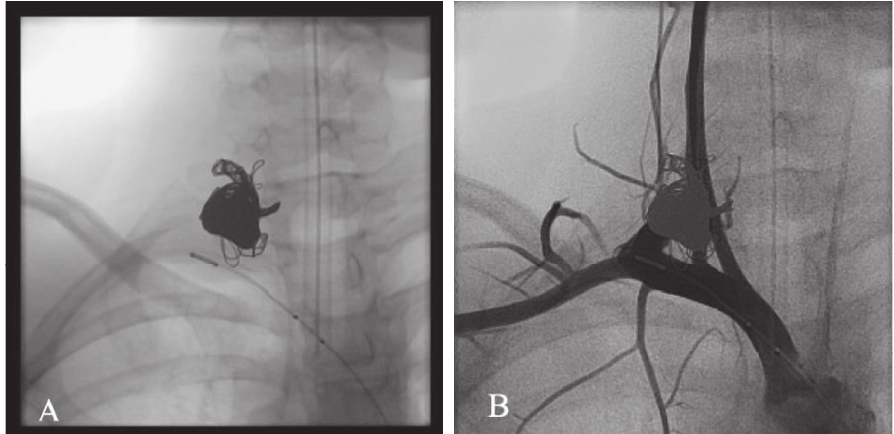
Figure 4: Images from the conclusion of the case demonstrating the mass of coils after occlusion (a) and filling of only normal arterial structures (b) on the postintervention angiogram.